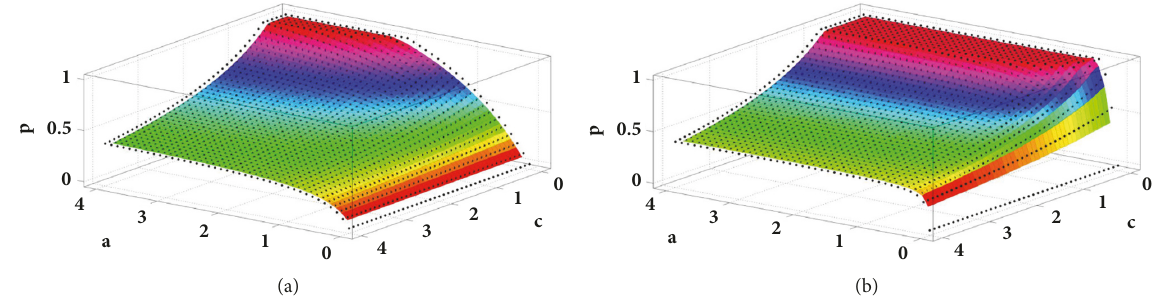
Figure 2: The relationship between the variables and the Nash Equilibrium solution. (a) The headway is equal to 1. (b) The headway is equal to 2.75.